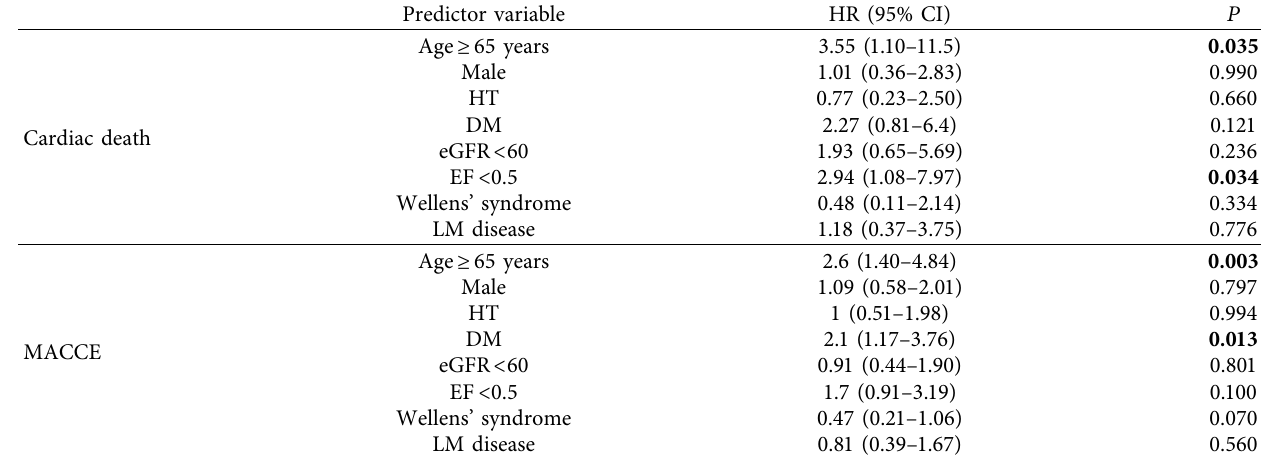
Table 4: Multivariate Cox regression analysis in the overall patients.